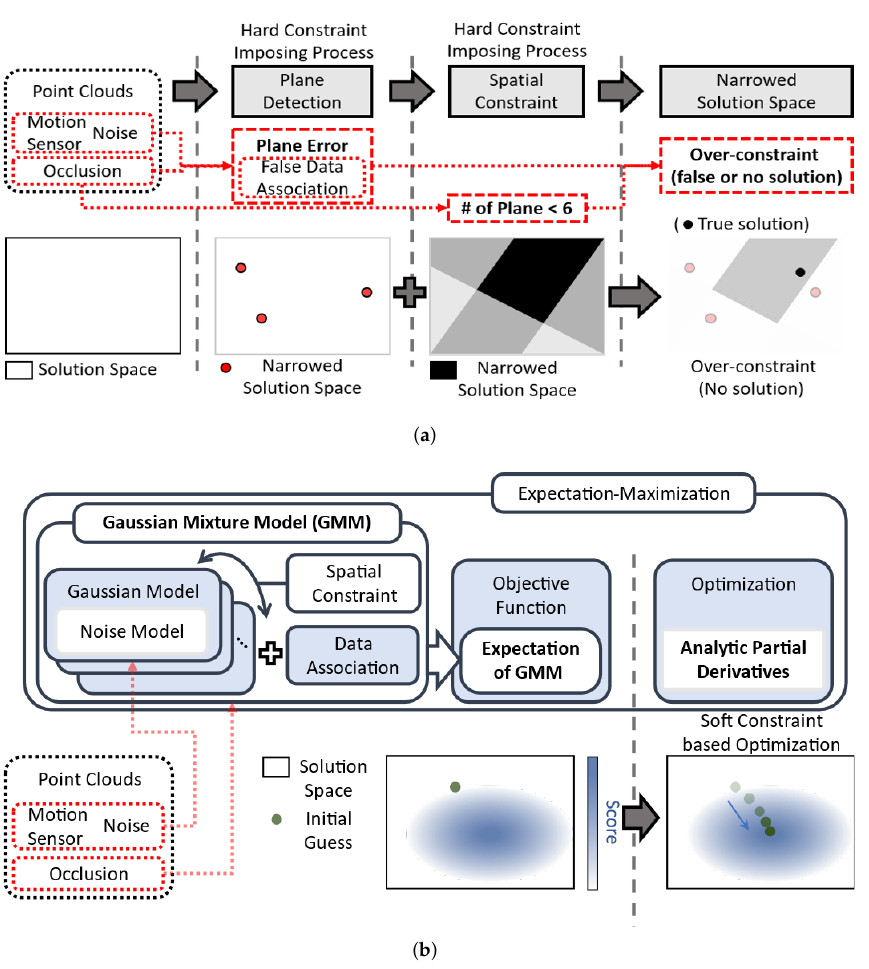
Figure 1. Comparison of cuboid modeling procedures. ( a ) Previous cuboid modeling method. Each hard constraint imposing process narrows solution space. ( b ) Proposed cuboid modeling method with GMM. Initial guess is iteratively optimized through the soft constraint that assigns score to solution